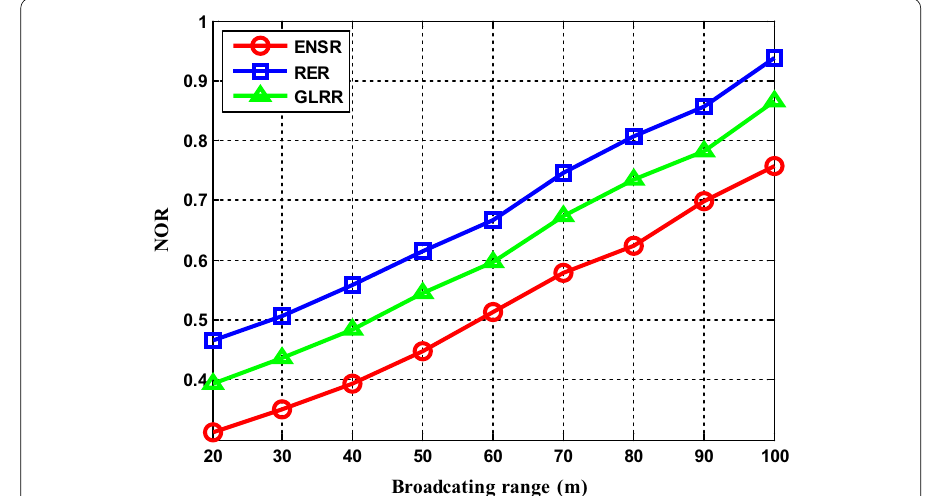
Fig. 8 NOR under different broadcasting range bR